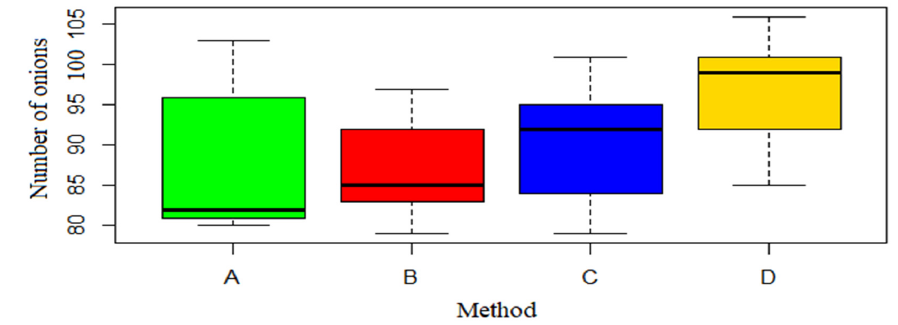
Figure 9. The number of all onions harvested from the plots.